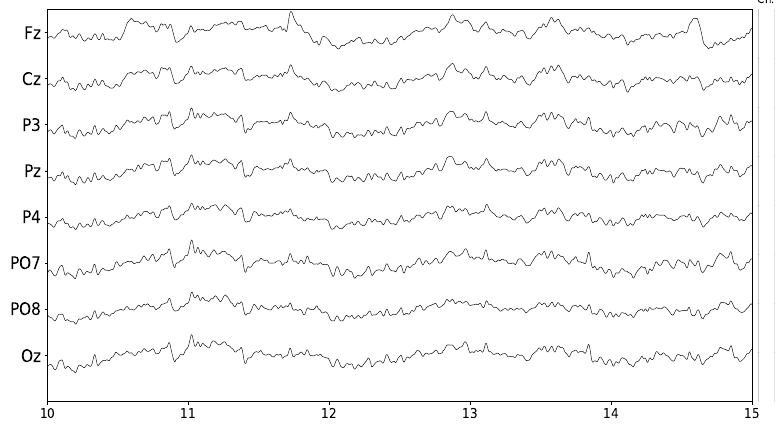
Help Figure 1. Sample EEG signal obtained from g.Tec g.Nautilus. Time axis is in seconds and five seconds are displayed. The eight channels provided by this device are